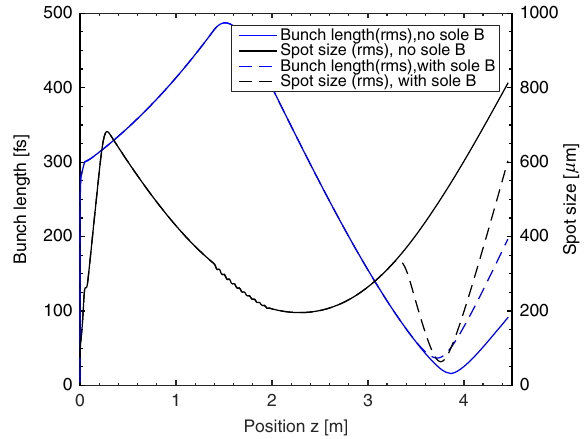
FIG. 3. The evolutions of bunch length and transverse beam size in the velocity bunching scheme with and without solenoid focusing before CTR